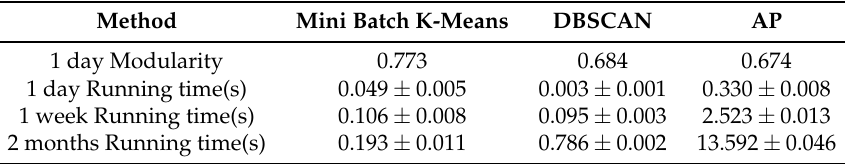
Table 1. Running time of different clustering methods.